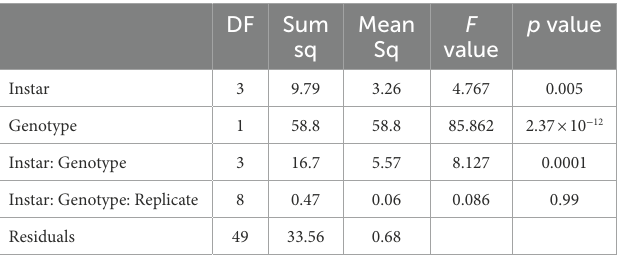
TABLE 3 Anova (nested analysis of variance)